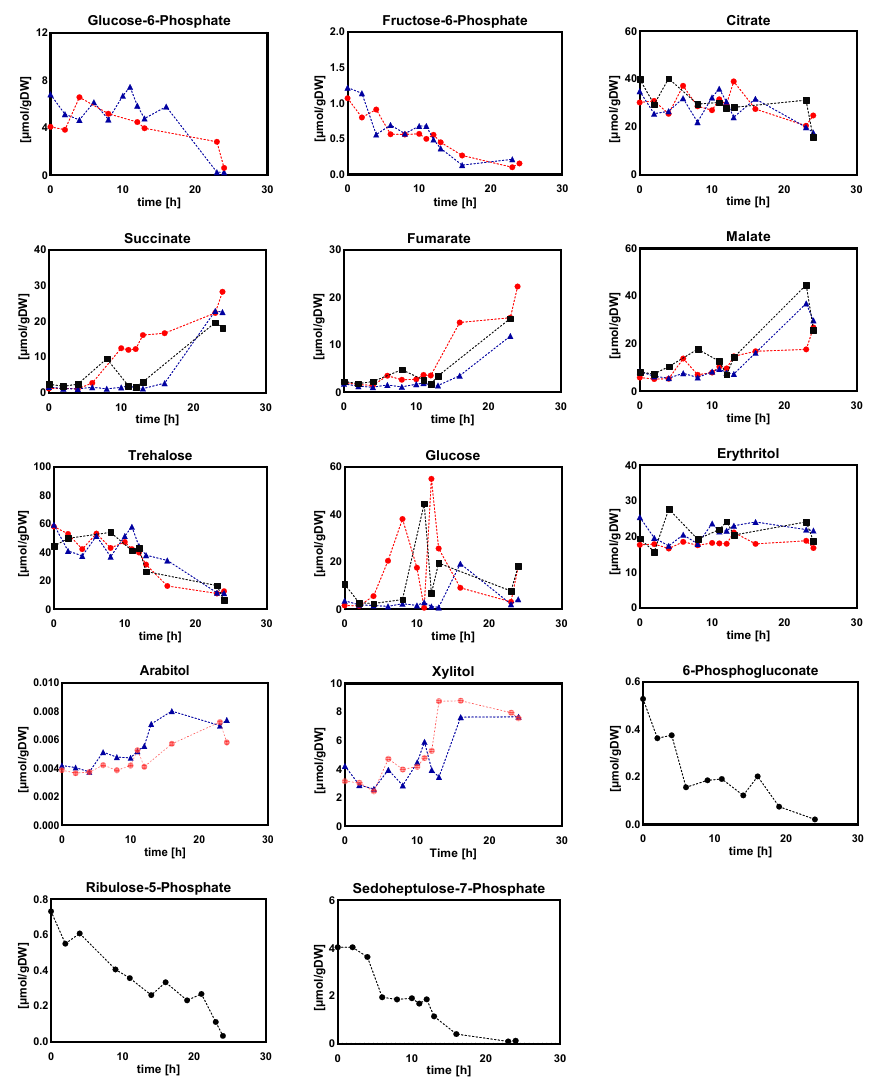
Figure 13. Intracellular amounts of sugar phosphates, organic acids, and sugar alcohols in Penicillium chrysogenum Wisconsin 54-1255 under DO ramp-down experiments. The dissolved oxygen was linearly decreased from 60% to 0% in 24 h. Time 0 represents the start of DO ramp-down. Three legends represent three replicate